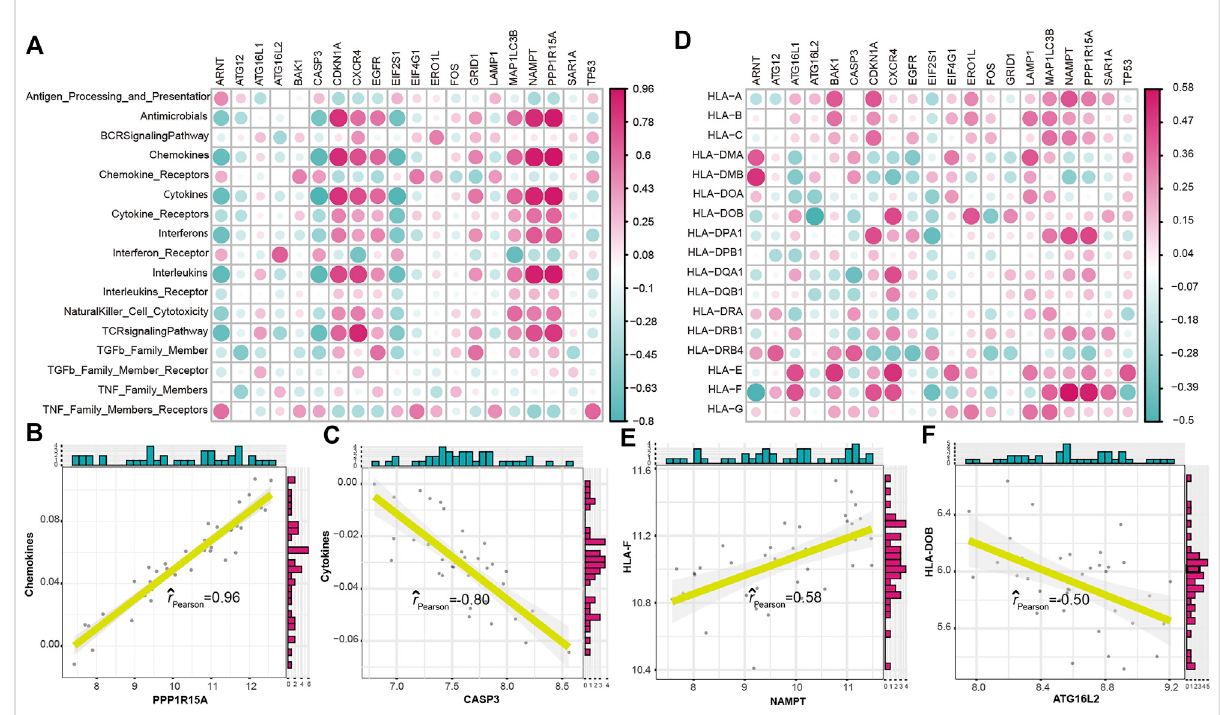
FIGURE 4 Correlation between immune reactions or HLA genes and dysregulated autophagy genes. (A) Dot plot showed the correlations between each immune reaction and each dysregulated autophagygene. (B) Most positivelycorrelated immune reaction – autophagy gene pair. (C) Most negatively correlated immune reaction – autophagy gene pair. (D) Dot plot showed thecorrelations betweeneach HLA gene and each dysregulated autophagy gene. (E) Most positively correlated autophagy – HLA gene pair. (F) Most negatively correlated autophagy – HLA gene pair.